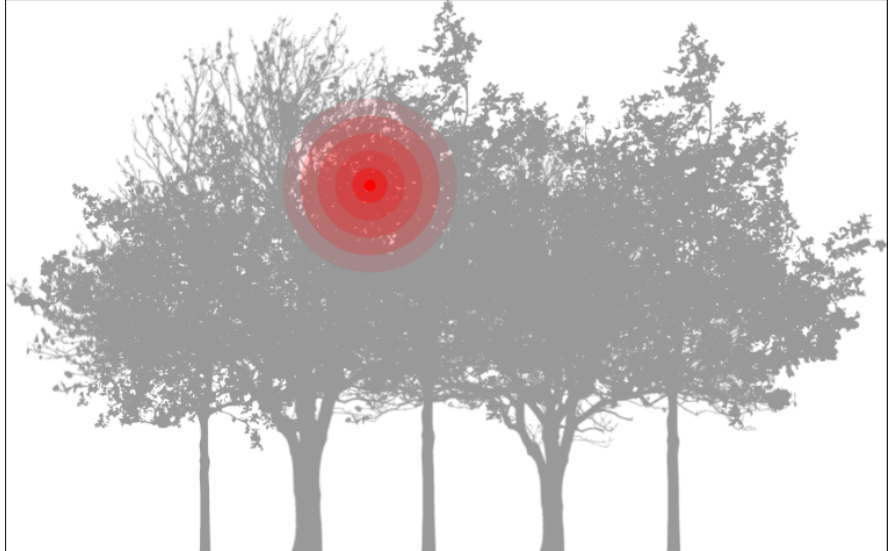
Figure 2. Example of a possible location for a disease spread. We model this spread using a spatially- distributed probability density function